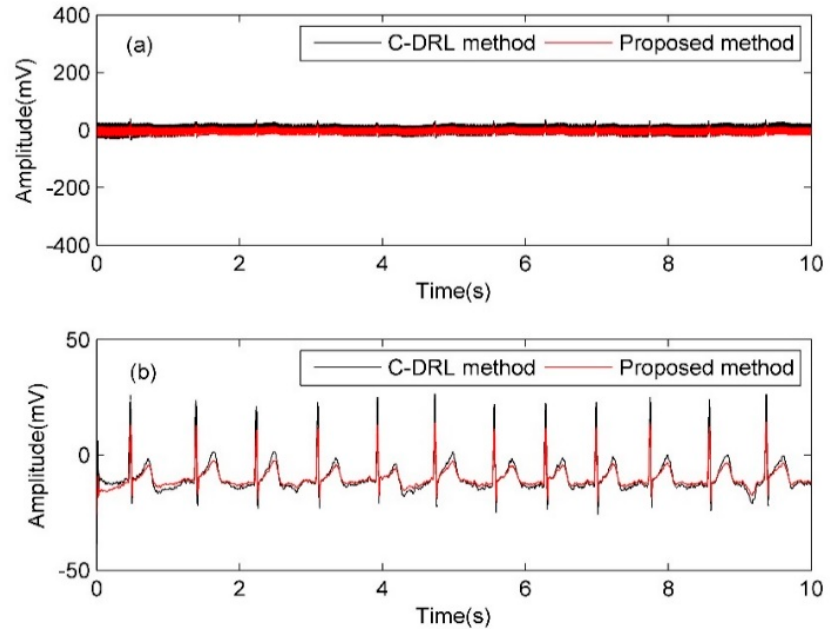
Figure 12. Simultaneous measurement results of human chest ECG acquisition with interface impedance match under static condition, ( a ) time-domain waveform of original signal, ( b ) ECG signal processed by software notch.